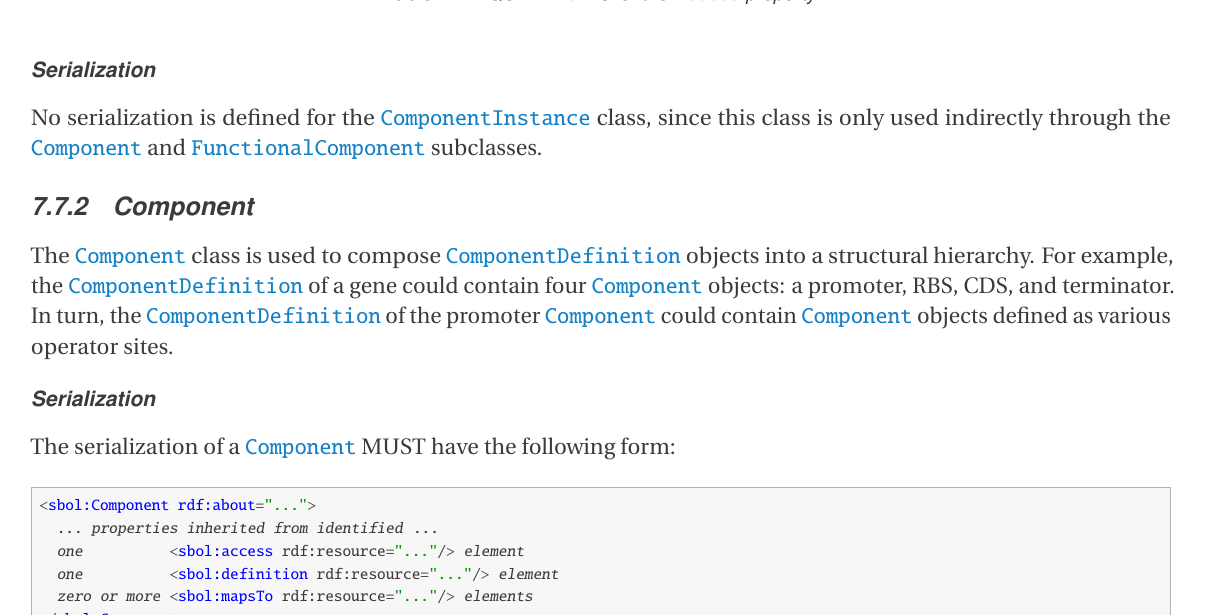
Table 4: REQUIRED URI s for the access property.